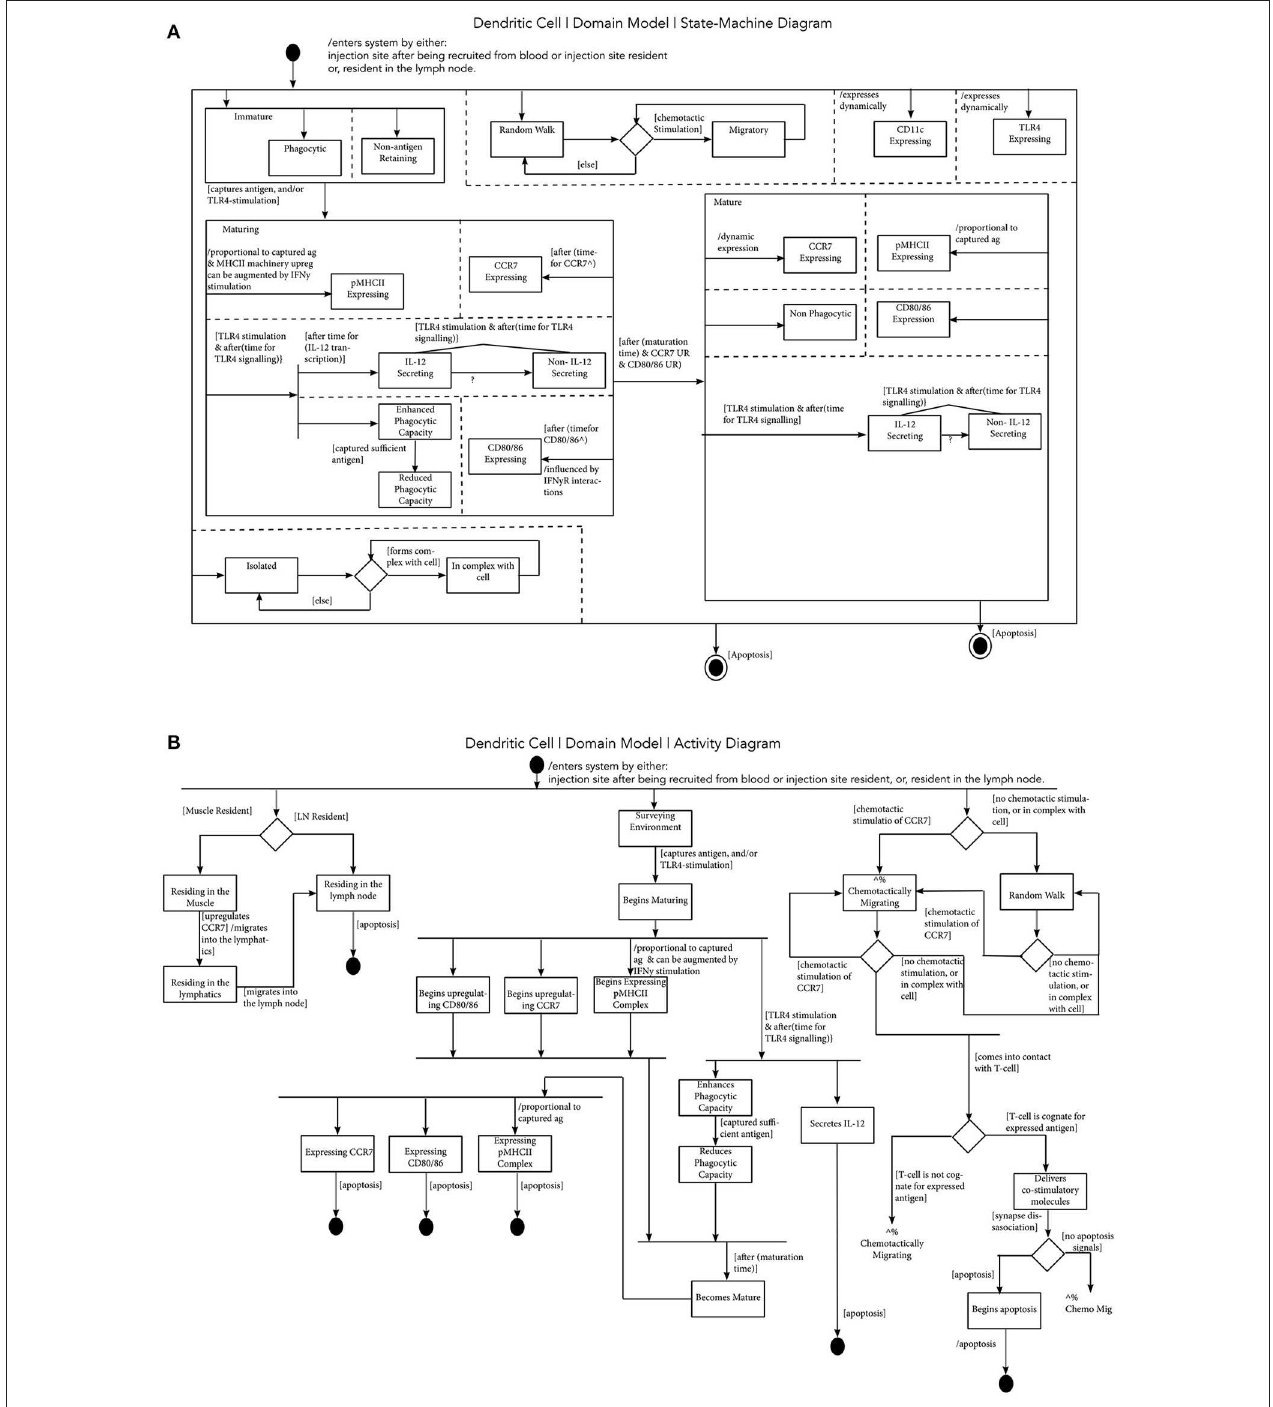
FIGURE 2 | Modeling Dendritic Cell Function. (A) A Dendritic Cell State-Machine Diagram: states are represented by rectangular boxes, which may encompass smaller rectangular boxes, indicating parent and sub-states, respectively. A black circle indicates the initial state of the object, and the “double” circle indicates the final state. Arrows indicate transitions between the states, and information surrounded by square brackets describe a condition that must be satisfied for the transition to proceed. An expression preceded by a forward slash, indicates further information with respect to a state transition or a state. Finally, dashed lines represent concurrent states and a diamond indicates a decision is to be made, determined by a condition being satisfied. (B) A Dendritic Cell Activity Diagram: in this diagram, a black circle indicates the start of processes, and a double circle indicates the end of activities. The rectangles indicate activities and diamonds represent decisions. Horizontal black lines, are forks and joins, which indicate, respectively, the start and end of activities that occur concurrently.